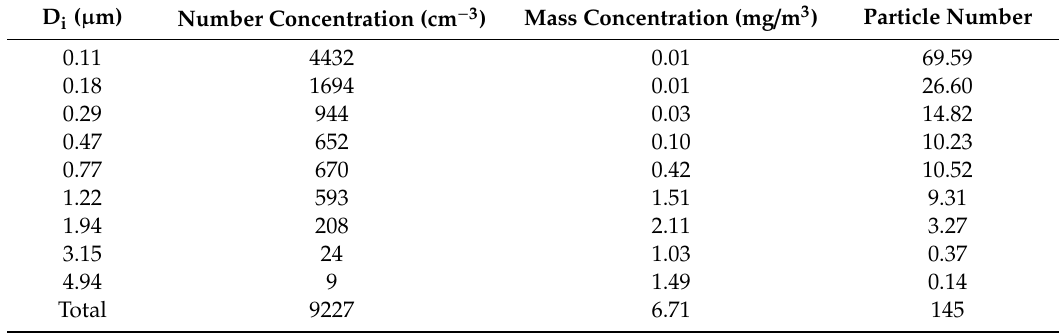
Figure 9. Real-time readings of mass concentration measured using the reference method and scattering light intensity during the experiment of sample A at a scattering angle of 45° within 1 min. Table 2. The particle concentration and number of sample A with a size greater than 0.1 μ m.